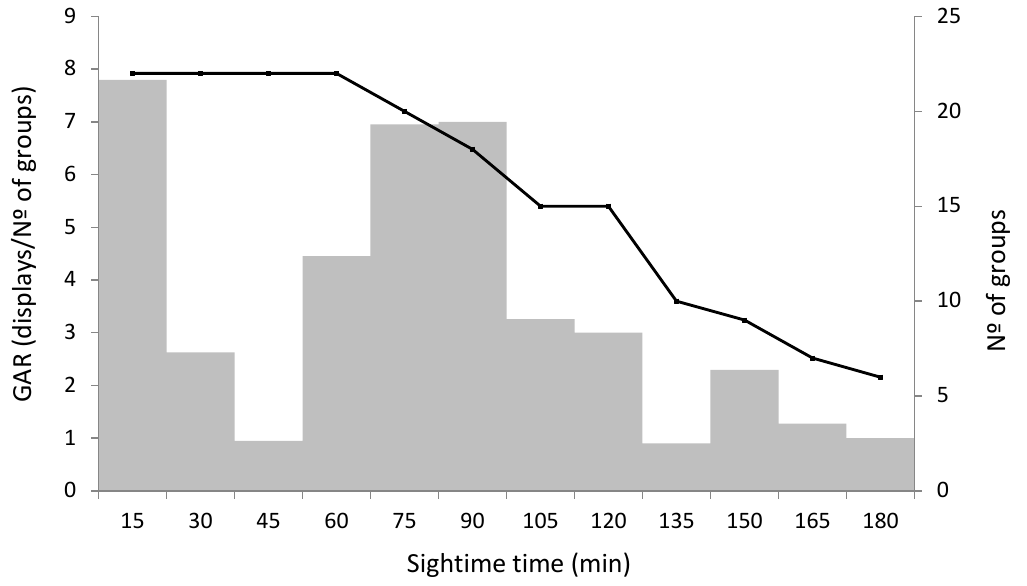
Figure 5. Average group activity rate (GAR) (displays/# of groups) performed by whales in competitive groups in Ecuador during the first three hours of following. Line with dots indicates the number of groups used to calculate GAR according the scale of the right